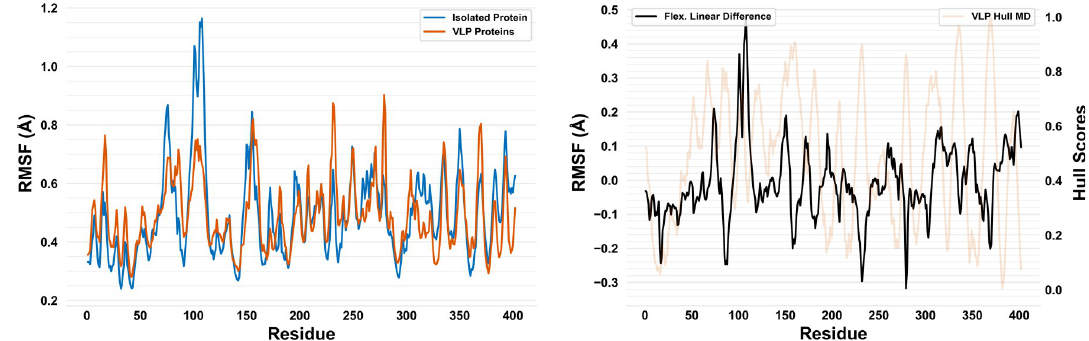
Fig 3. Visualizing the linearly combined, flexibility model via RMSF profiles. On the left, plots of the weighted isolated (blue trace) and VLP (red trace) protein flexibility metrics vs. residue number are overlaid. On the right, a plot of the linearly combined, flexibility model (black trace; using weights which minimized the root-mean-square difference between the two flexibility-based metrics) vs. residue number is shown. For comparison, on the right, a plot of VLP hull scores (red trace) is shown behind a plot of the linearly combined, flexibility